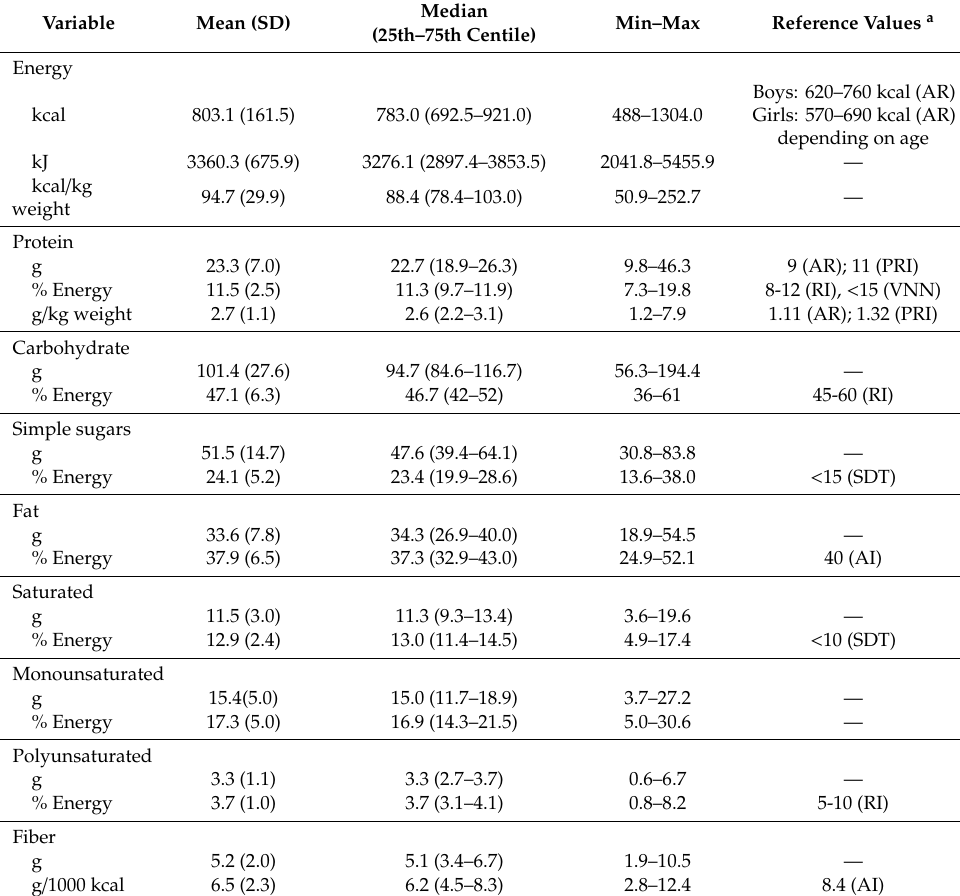
Table 3. Daily dietary intake of energy and macronutrients in infants aged 6 ≤ months < 12 ( n =